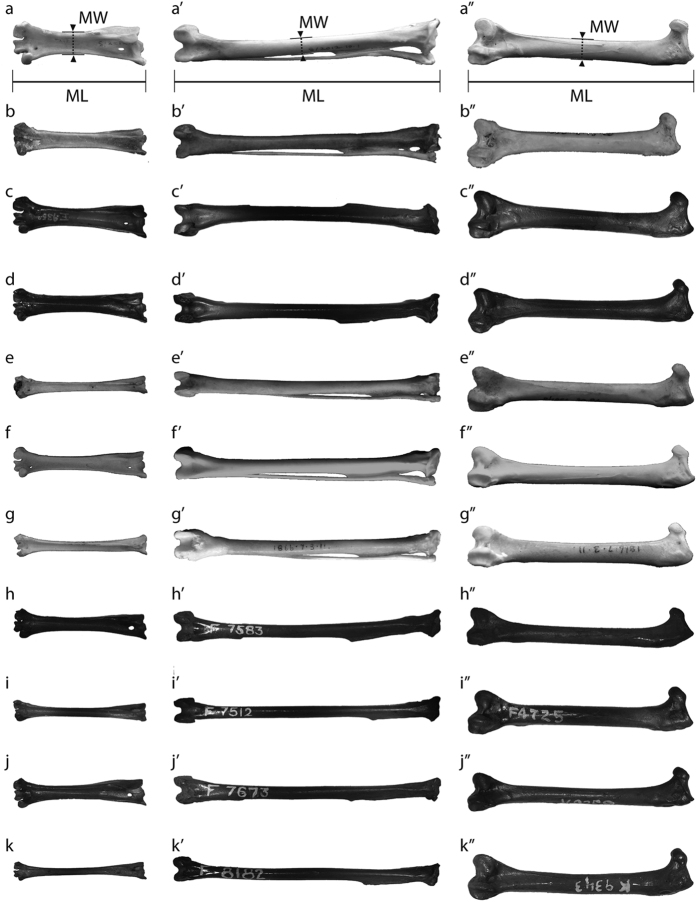
Exemplar right owl limb elements in posterior view, organised by decreasing body mass.Elements are scaled to equal length to highlight differences in robusticity. x = tarsometatarsus; x’ = tibiotarsus; x” = femur. (a–a”) Nyctea scandiaca; (b–b”) Ketupa ketupu; (c–c”) Bubo virginianus; d-d”) Oraristrix brea; (e–e”) Tyto novaehollandiae; (f–f”) Strix aluco; (g–g”) Tyto capensis; (h–h”) Asio flammeus; (i–i”) Tyto alba; (j–j”) Asio otus; (k–k”) Athene cunicularia. Bubo virginianus tibiotarsus (c’) shows left element due to lack of right-hand specimens. Fossil specimens (c,d,h-k) do not necessarily represent elements from one individual. Specimens (a,b,e–g) ©The Trustees of the Natural History Museum, London. MW: midshaft width; ML: maximum length.